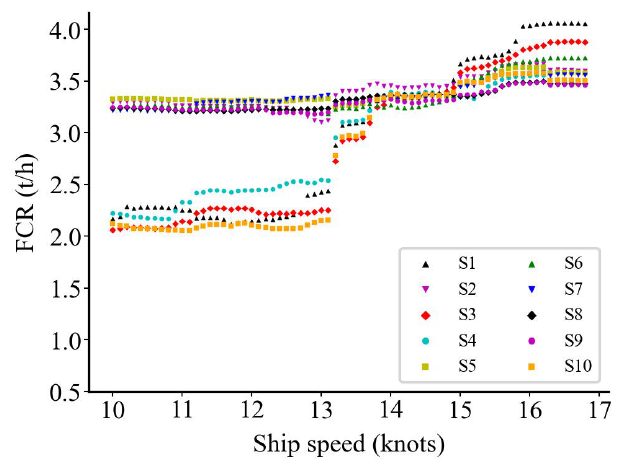
Figure 16. RF model prediction results.